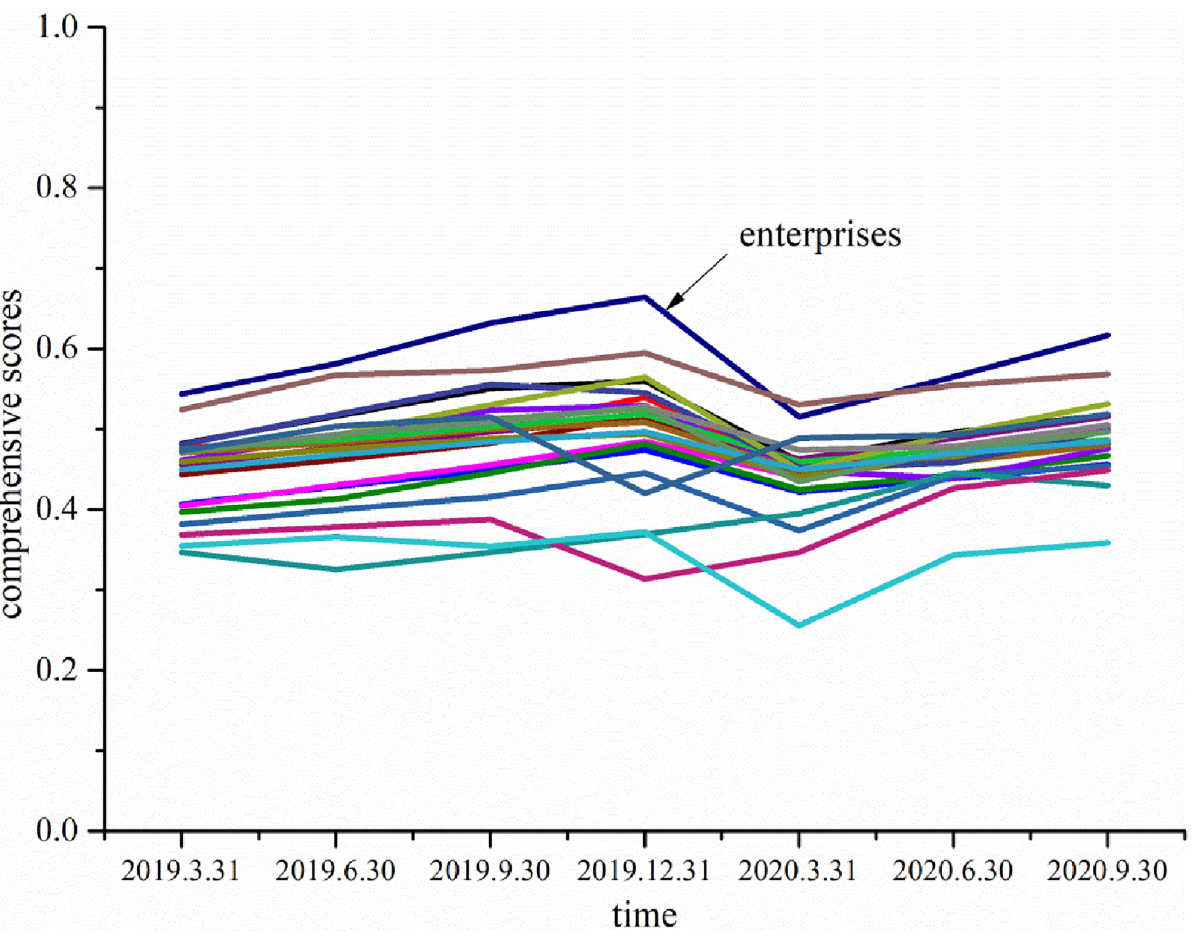
Fig 1. Comprehensive score of enterprises in each